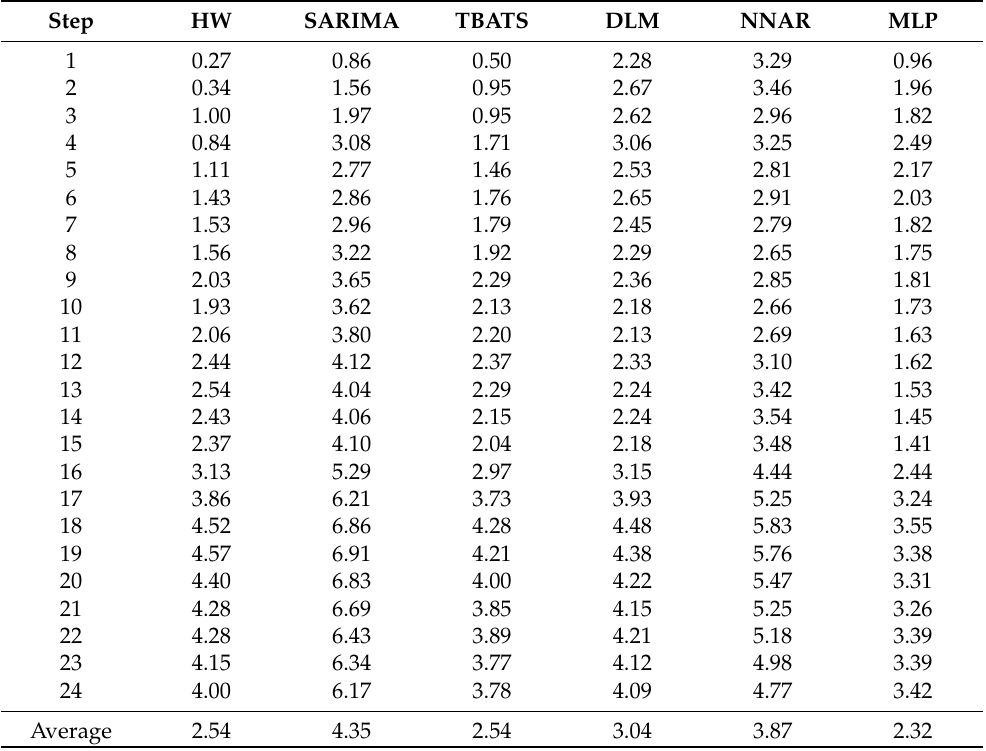
Table 3. Mean absolute percentage error, considering the six models, for h = 1,...,24 steps-ahead out-of-sample forecasts applied to the electricity consumption of the Brazilian